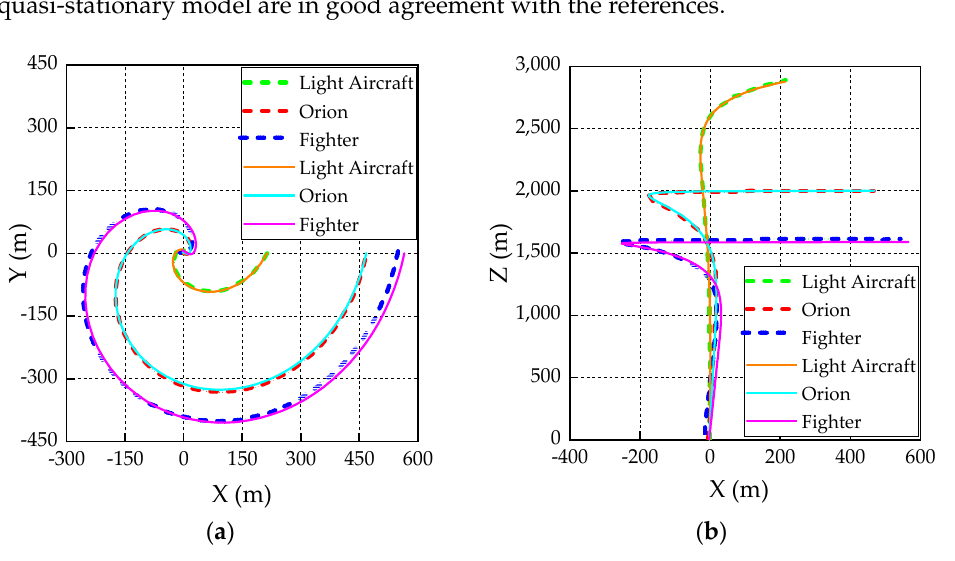
Figure 2. Verification of towing cable spatial configuration. ( a ) Two-dimensional projection in horizontal plane. ( b ) Two-dimensional projection in vertical plane.